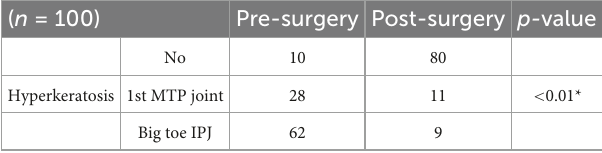
TABLE 2 Hyperkeratosis: pre-and post-surgery results and χ 2 test.